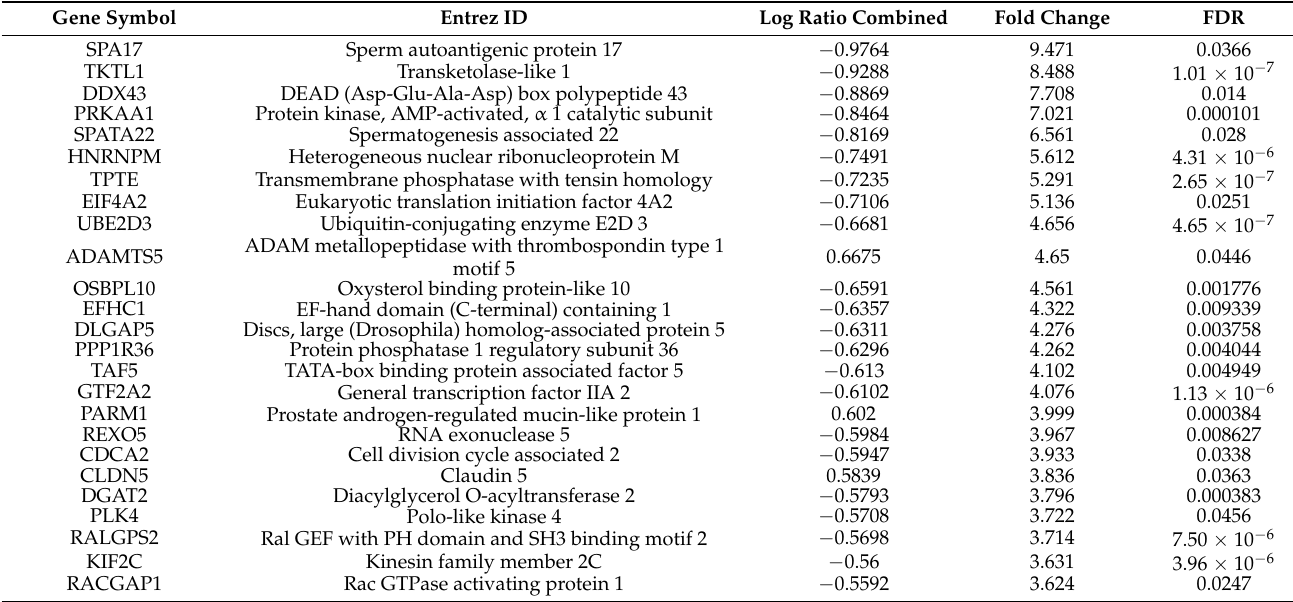
Table 2. The top 25 up-regulated and down-regulated genes that have been found to be common to teratozoospermia and azoospermia using ExAtlas and Network Analyst are listed along with their Entrez ID, log-ratio combined, and fold change value (FDR).